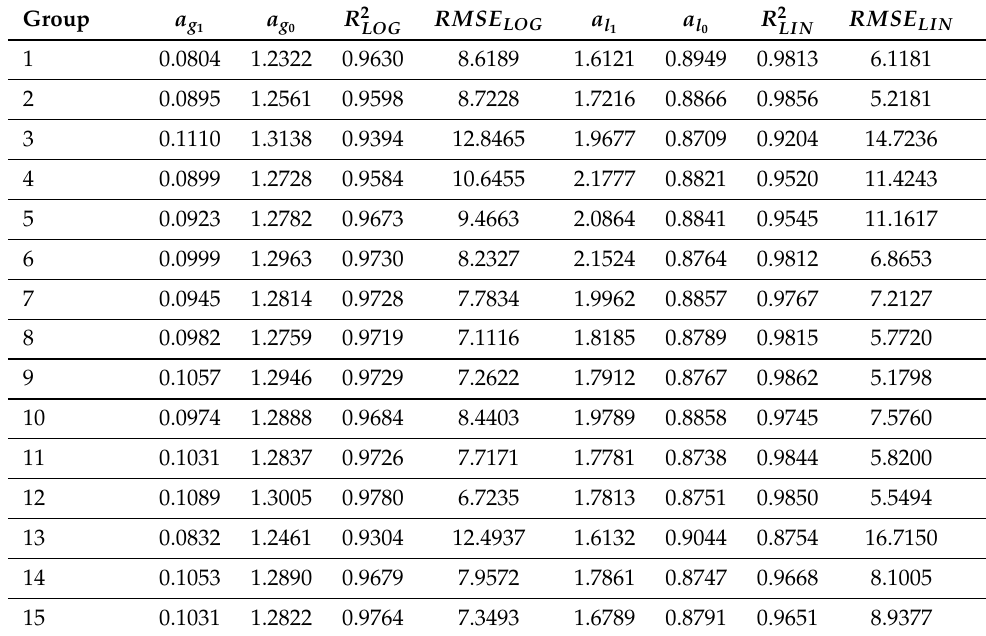
Table 3. Values of a g computed for the 15